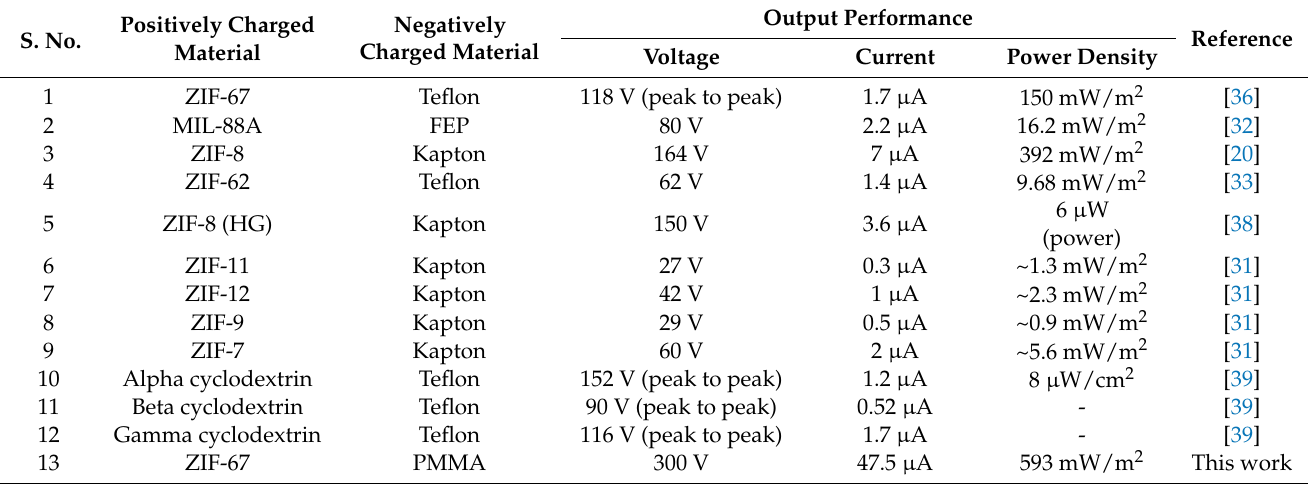
Table 1. Comparison of ZIF-based TENG device performances reported in the